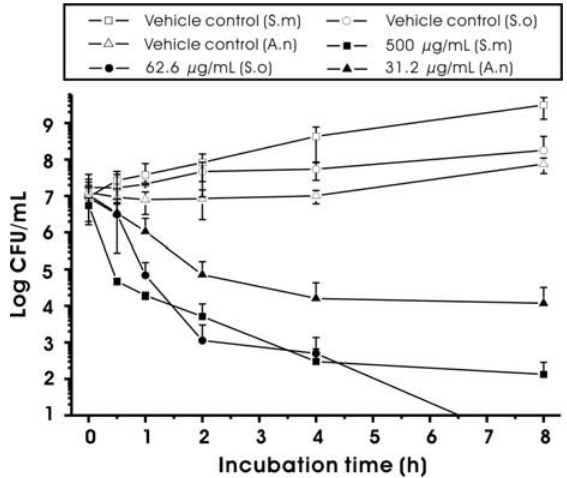
2. Minimum inhibitory concentration (MIC) and minimum bactericidal concentration (MBC) of methanol extracts from Dryopteris crassirhizoma root. Test bacteria MIC ( μ g/mL) MBC ( μ g/mL) Streptococcus mutans UA159 62.5 250 Streptococcus oralis 35037 15.6 31.3 Actinomyces naeslundii 12104 7.8 15.6 Vehicle control (1% DMSO, v/v, final concentration) did not show inhibitory effect on the growth of the bacteria tested. Figure 2. Time-kill curves for Streptococcus mutans (S.m), Streptococcus oralis (S.o) and Actinomyces naeslundii (A.n) in the presence of methanol extract of Dryopteris crassirhizoma root (MED). The final concentrations of MED were two times of MBCs against the bacterial species tested. The vehicle controls were 1% DMSO (v/v, final concentration). Data represent mean ± standard